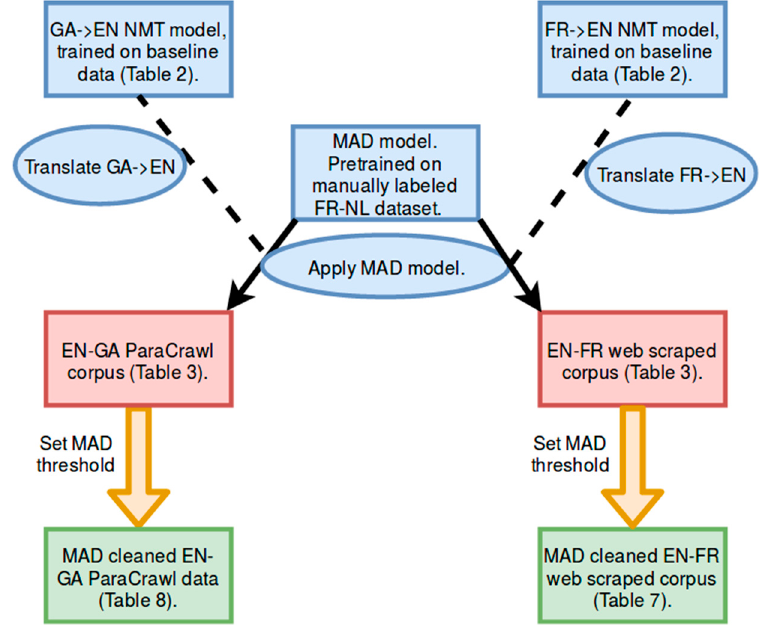
Figure 1. Overview of the relationship among the various datasets and models used.